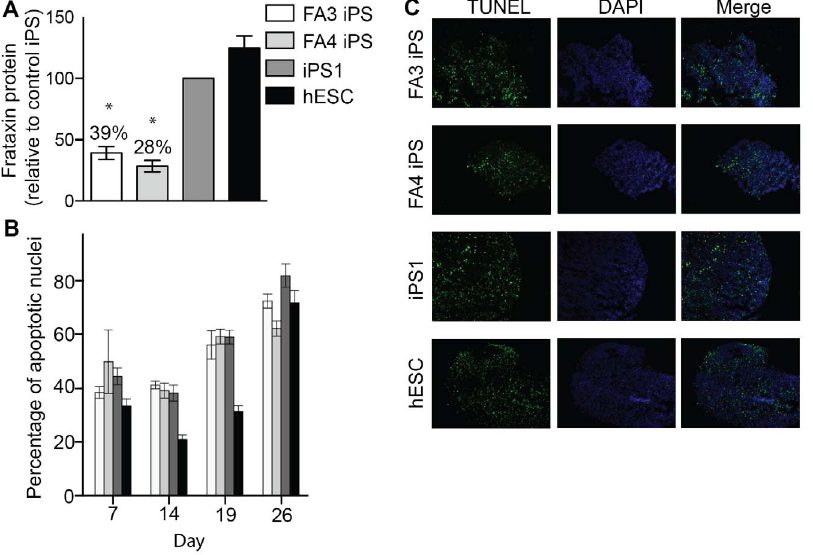
Figure 3. Frataxin expression and level of cell death in neurospheres derived from FA iPS cells. ( A ) Frataxin protein was measured in cell lysates using immuno-capture dipsticks and quantified relative to the control iPS line. N=3 experiments, with at least 12 neurospheres per sample for each replicate experiment ( B ) Levels of cell death in neurospheres cultured for 7–26 days were determined by percentage of TUNEL expression. ( C ) Representative TUNEL staining images from day 26. N=3 separate experiments per time point, with at least 5 neurospheres per time point for each experiment. *p , 0.001. Error bars where shown =SEM.